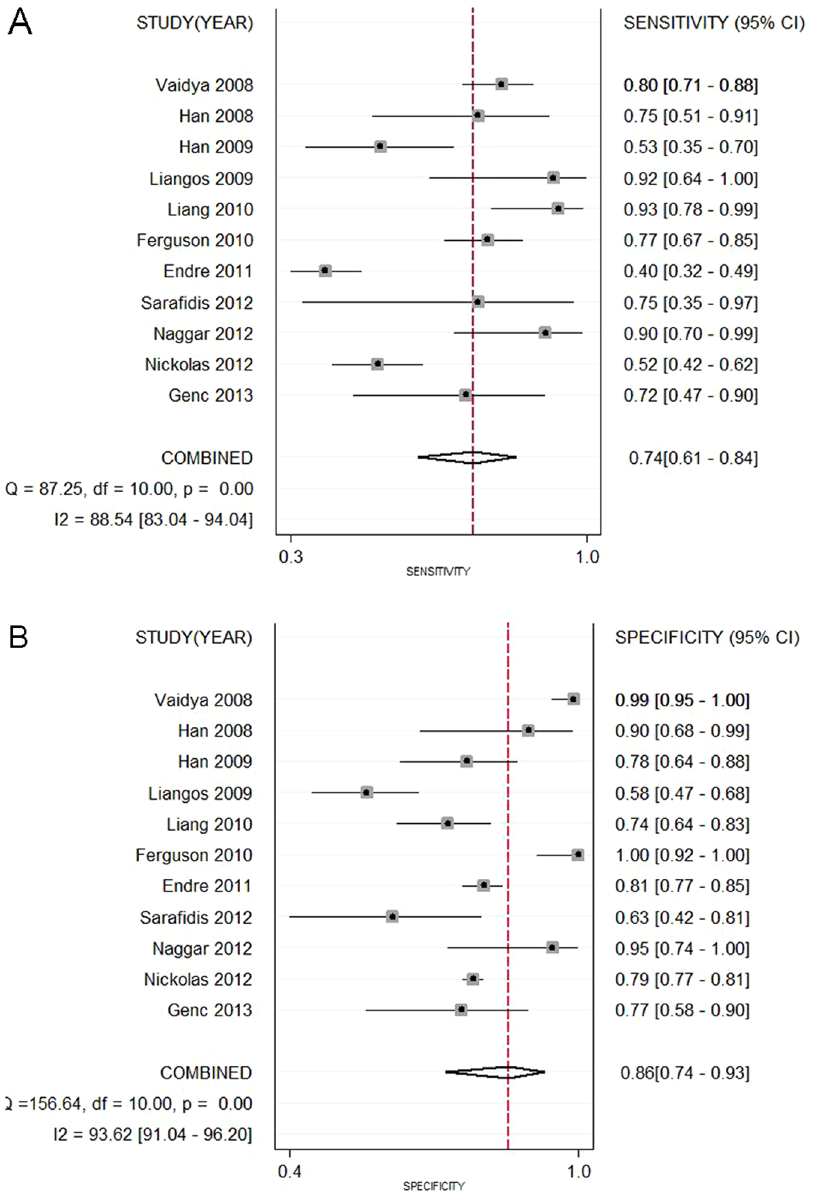
Figure 2. Forest plots of the pooled sensitivity (A) and specificity (B) of urine kidney injury molecule 1 level in predicting acute kidney injury across all settings. The black squares in the gray squares and the horizontal lines represent the point estimate and 95% confidence interval (CI), respectively. The dotted line represents the pooled estimate, and the diamond shape represents the 95% CI of the pooled estimate.